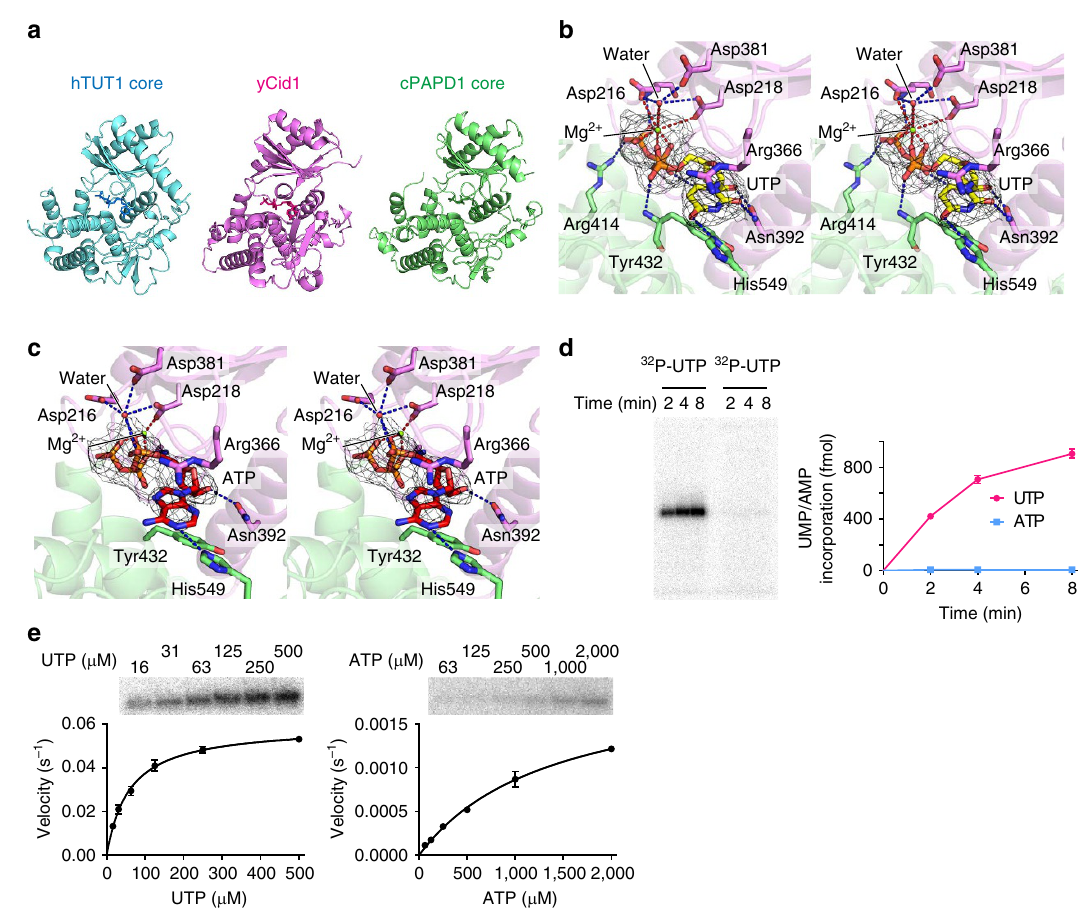
Figure 2 | Nucleotide recognition by human TUT1. ( a ) Structure of the catalytic domain of human TUT1. Comparison of the catalytic core domains of human TUT1 (amino-acid residues 145–598; left, cyan) with those of yeast Cid1 (amino-acid residues 42–381; middle, magenta) 21–23 and vertebrate mitochondrial PAP (PAPD1) (amino-acid residues 163–245 and 270–527; right, green) 24,37 . ( b ) UTP recognition by human TUT1. F o – F c omit map of UTP (yellow stick model) contoured at 3.0 s (coloured grey). ( c ) ATP recognition by human TUT1. F o – F c omit map of ATP (red stick model) contoured at 3.0 s (coloured grey). ( d ) Time-courses of UMP or AMP incorporation onto the 3 0 -end of the U6 snRNA-u4 transcript. ( e ) Steady-state kinetics of UMP (left) and AMP (right) incorporation into the U6 snRNA-u4 transcript, with various UTP (0–500 m M) and ATP (0–2,000 m M) nucleotide concentrations. Bars in the graphs indicate s.d. of two independent